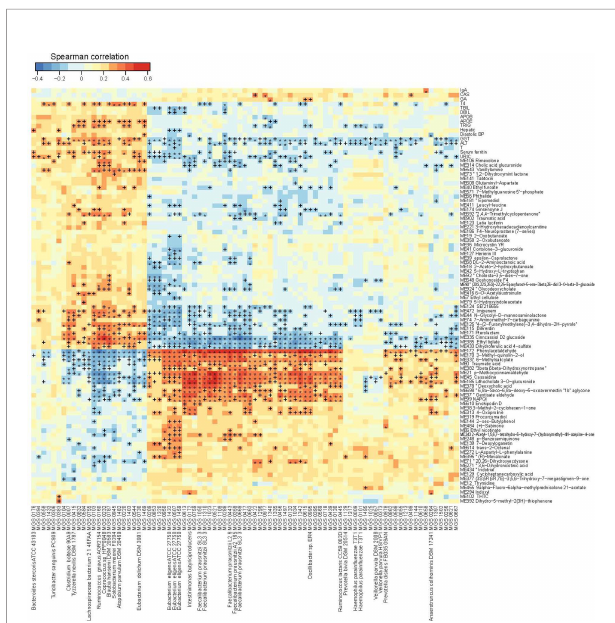
FIGURE 4 | Trans-omics correlations between the gut microbiome, the urine metabolome and clinical parameters. Correlations that reached statistical signi fi cance (Spearman correlation, p < 0.05) between MGS and clinical parameters, between metabolites and clinical parameters, and between MGS and metabolites, are shown in the heatmap. + q < 0.1; *q < 0.01. Color scale indicates the value of correlation coef fi